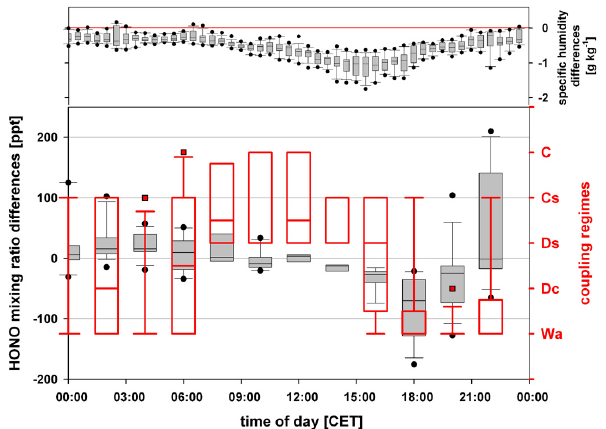
Fig. 6. HONO mixing ratio differences (grey bars, 10min aver- ages) and lifetime ratios (below to above canopy) (red bars, 30min averages) for the five-day dry period 20–25 September 2007 at the “Waldstein-Weidenbrunnen” research site. The upper end of the boxes represents the 75th percentile, the lower end the 25th per- centile and the line within the boxes the